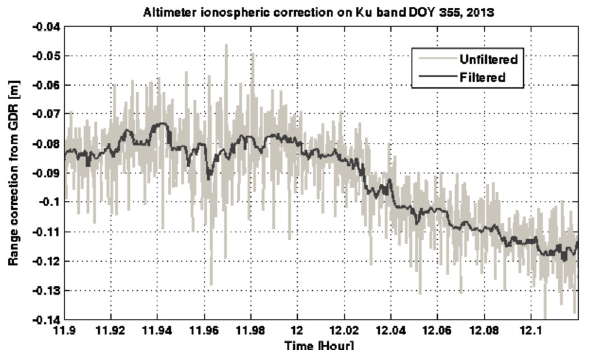
Figure 1. Sample filtered and unfiltered altimeter ionospheric range correction on Ku-band for the Jason-2 satellite, cycle 201 and pass